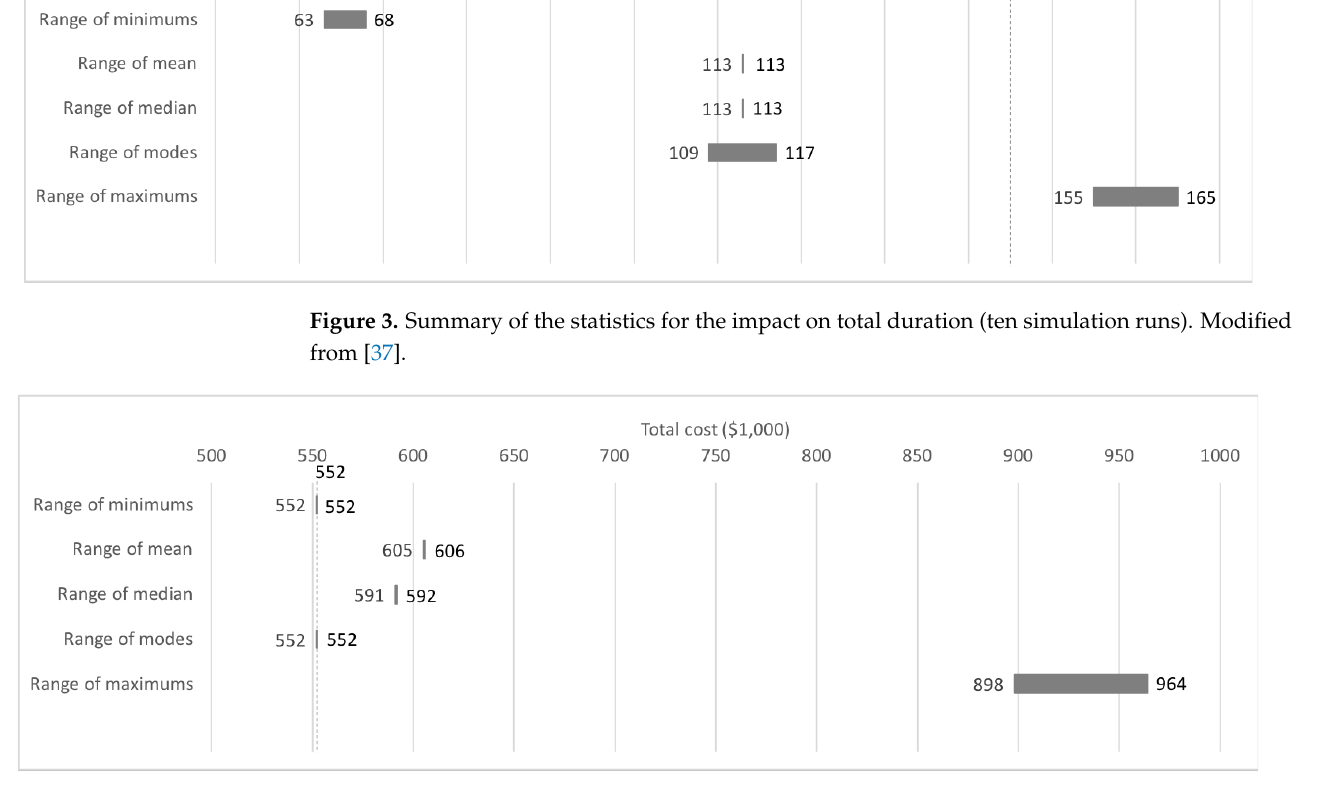
Figure 4. Summary of the statistics for the impact on total cost (ten simulation runs). Modified from [37].